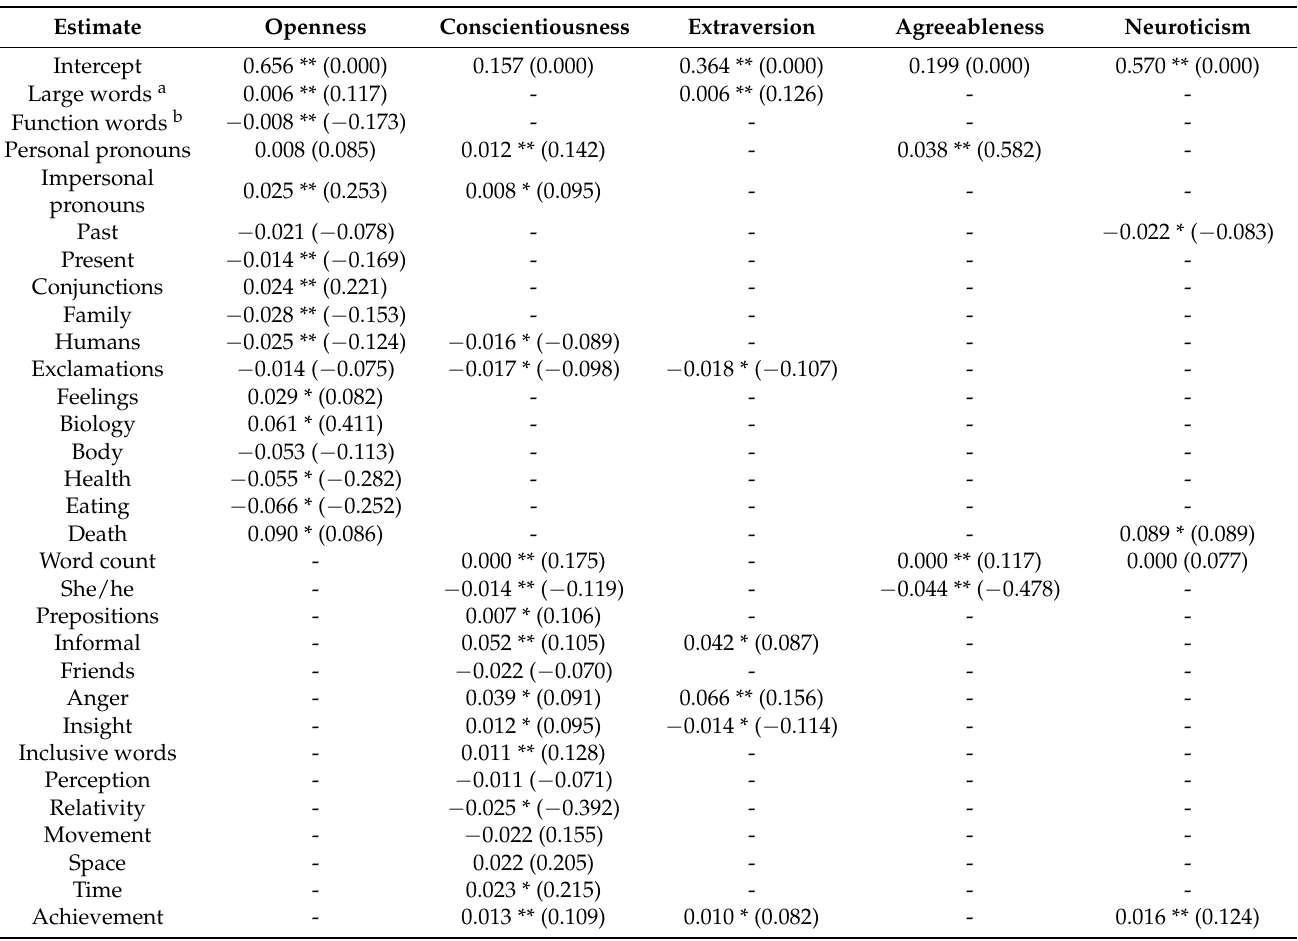
Table 2. Unstandardized (and standardized) estimates of the covariates/predictors of multiple linear regression models for each personality